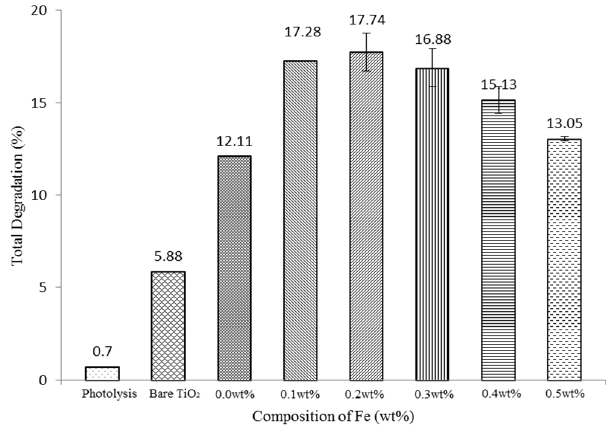
Figure 4. Efficiency of [bmim]Cl photodegradation system with different compositions of Fe; [IL o ] = 5 mM, pH = 8 and [photocatalyst] = 1 g/L.